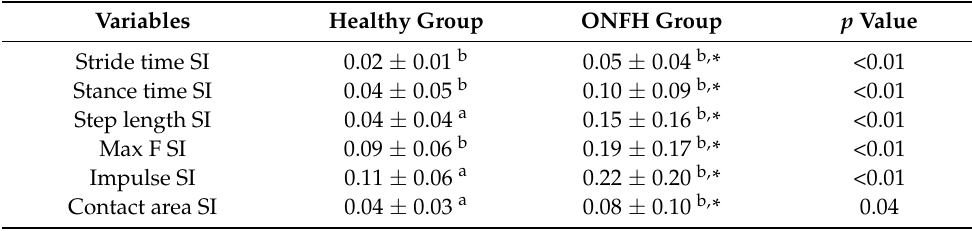
Table 7. Comparison of ONFH and healthy